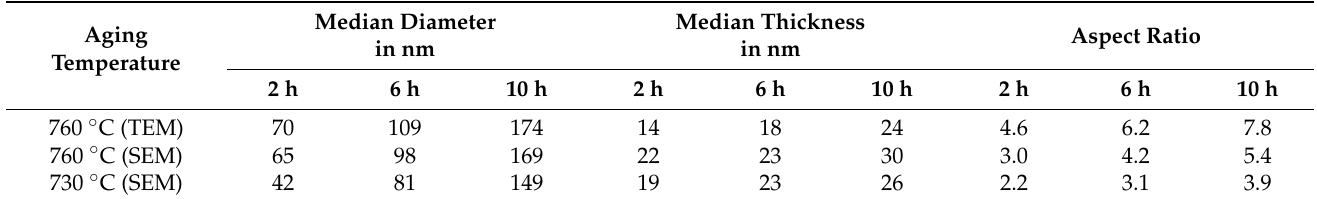
Figure 5. Exemplary TEM and SEM micrographs showing the γ′′ precipitates after aging. The TEM investigations were done on samples aged at 760 °C for 2 h, 6 h and 10 h (top row). SEM studies were performed on samples aged at 760 °C (middle row) and at 730 °C (bottom row) for 2 h, 6 h and 10 h. Table 3. Medians of the diameter, thickness and aspect ratio of the γ (cid:48)(cid:48) particles measured by means of TEM and SEM after different aging